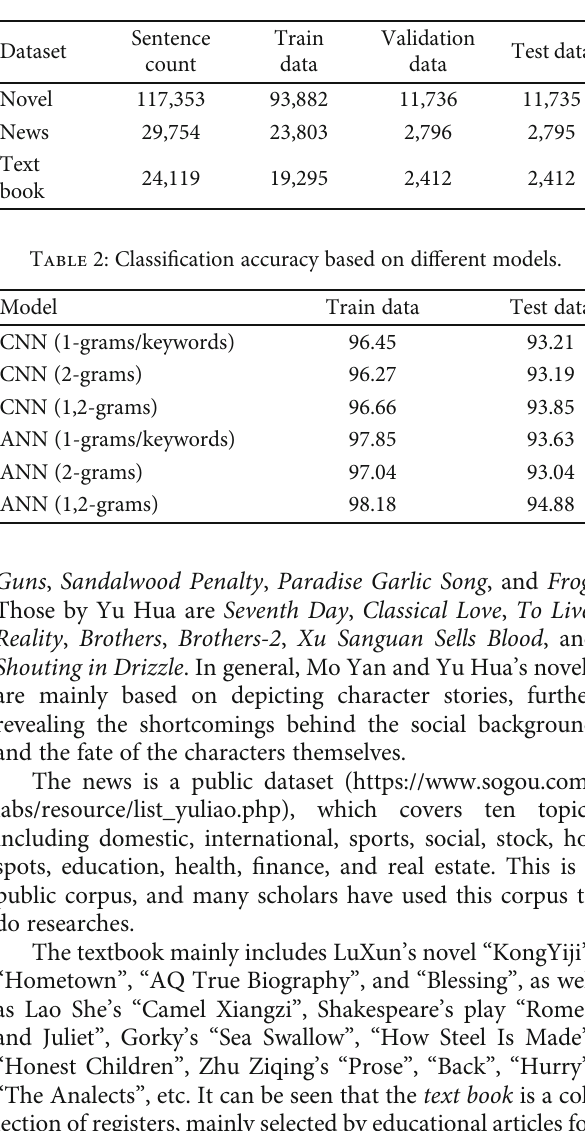
Table 1: Statistics of the dataset.